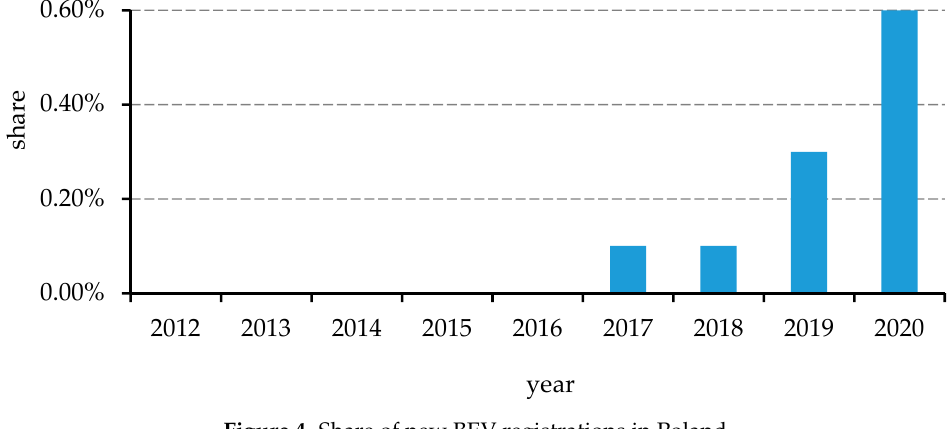
Figure 4. Share of new BEV registrations in Poland.